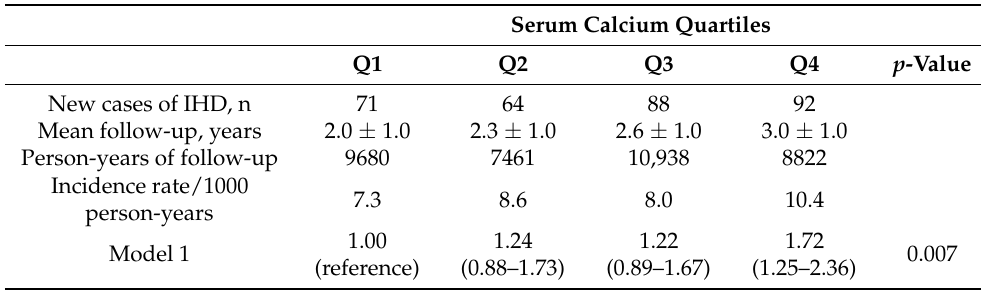
Table 3. Hazard ratios and 95% confidence intervals for new-onset ischemic heart disease (IHD) according to serum calcium